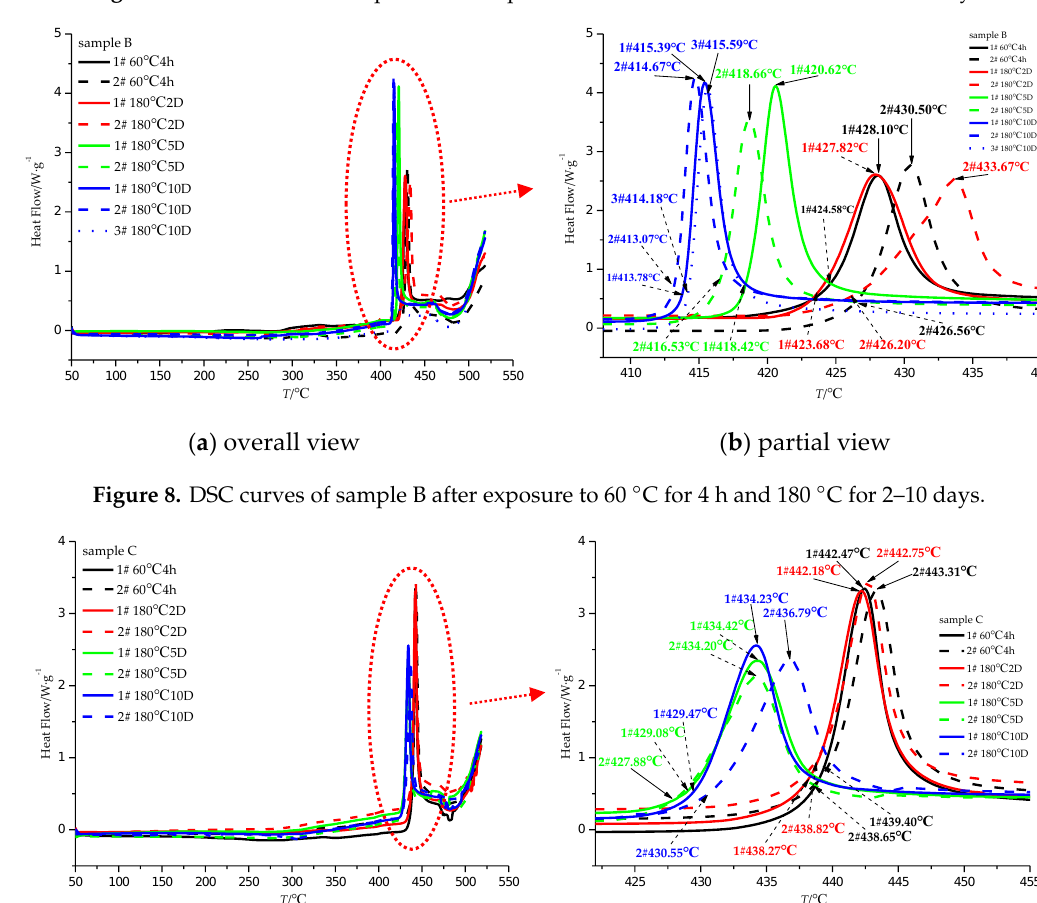
Figure 7. DSC curves of sample A after exposure to 60 °C for 4 h and 180 °C for 2 – 10 days.